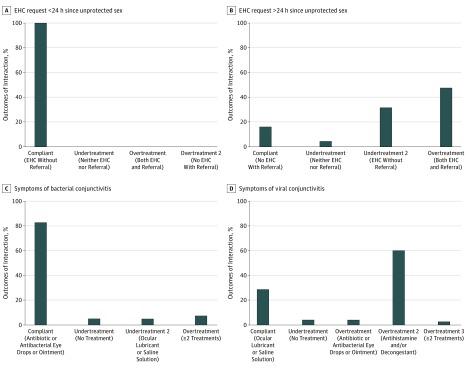
Distribution of Observed Treatment Outcomes by ScenarioA, Scenario 1: emergency hormonal contraceptive (EHC) request less than 24 hours since unprotected sex (n = 45). B, Request for EHC more than 24 hours since unprotected sex (n = 44). C, Scenario 2: conjunctivitis symptoms indicative of bacterial conjunctivitis (n = 81). D, Conjunctivitis symptoms indicative of viral conjunctivitis (n = 73). Compliant, overtreatment, and undertreatment conditions are as defined in Table 1.